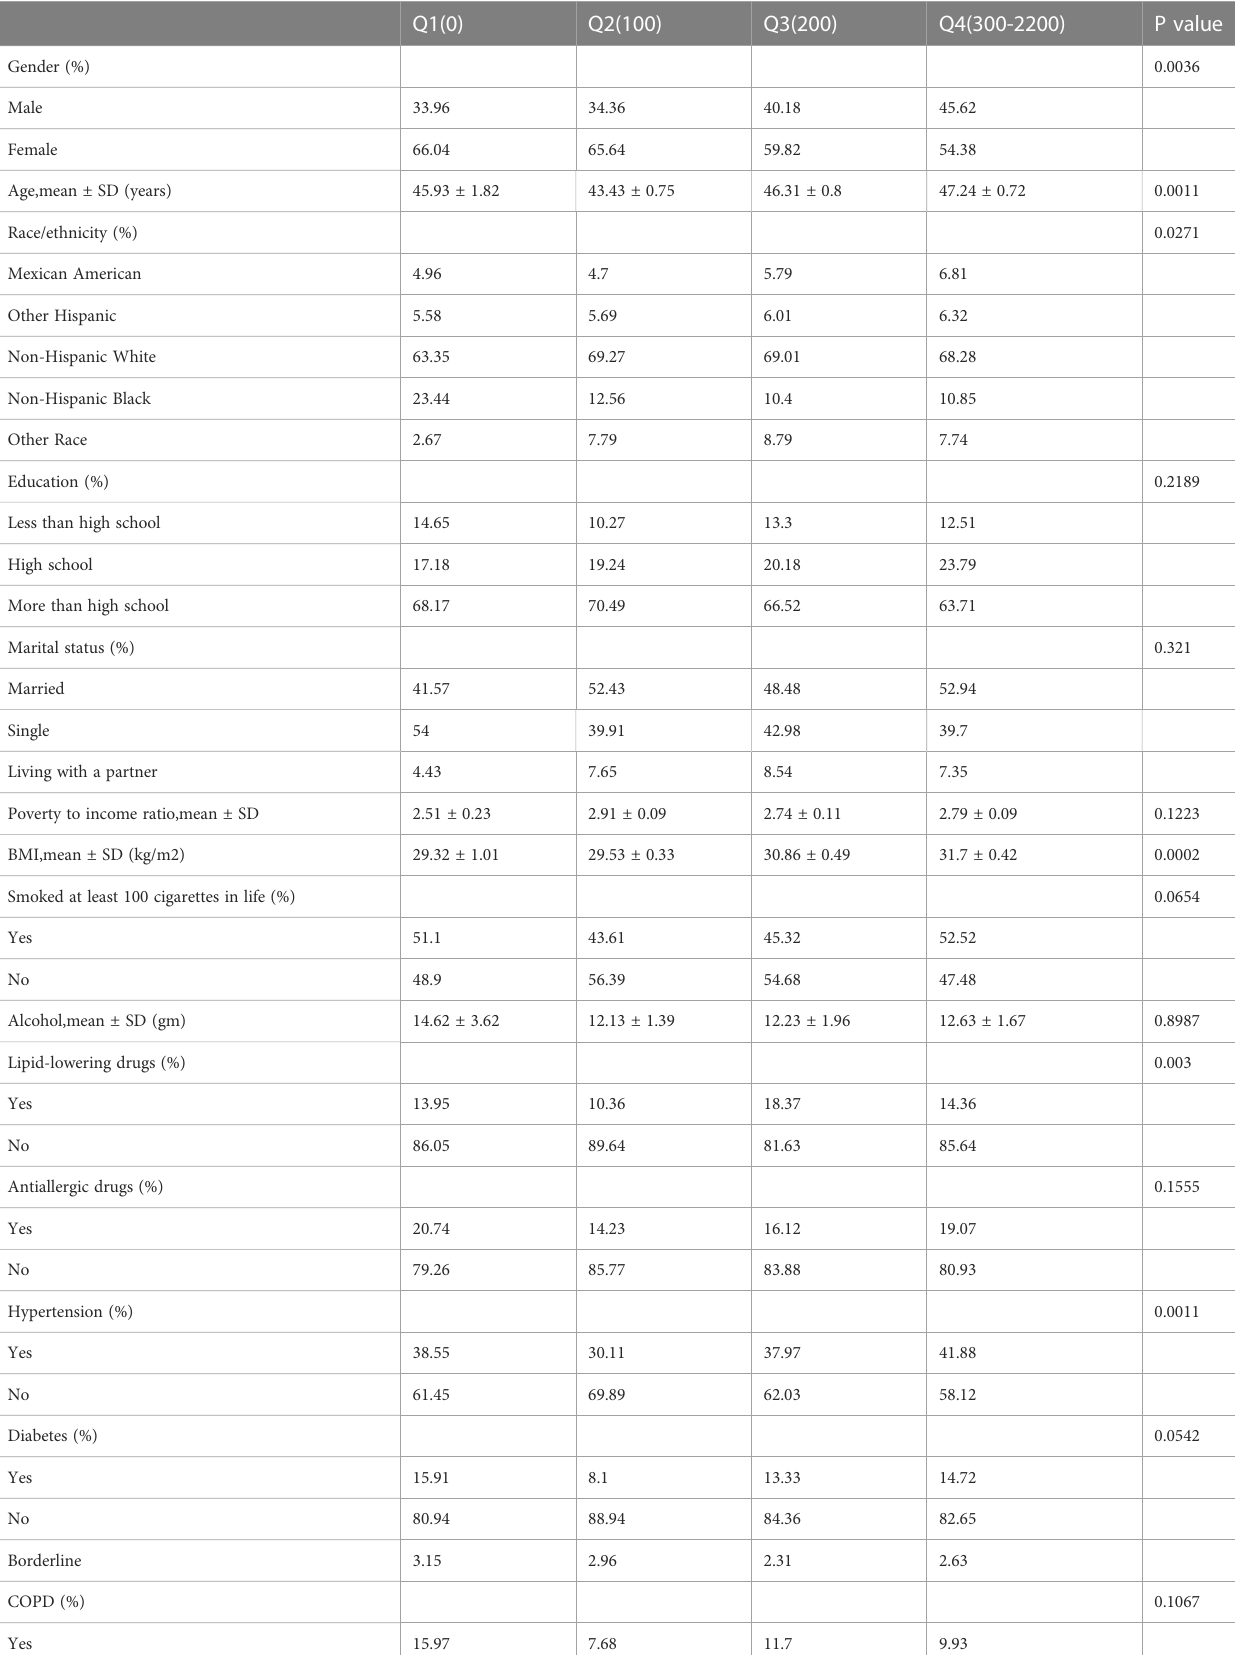
TABLE 1 By quartiles of blood eosinophil counts, weighted characteristics of study individuals are